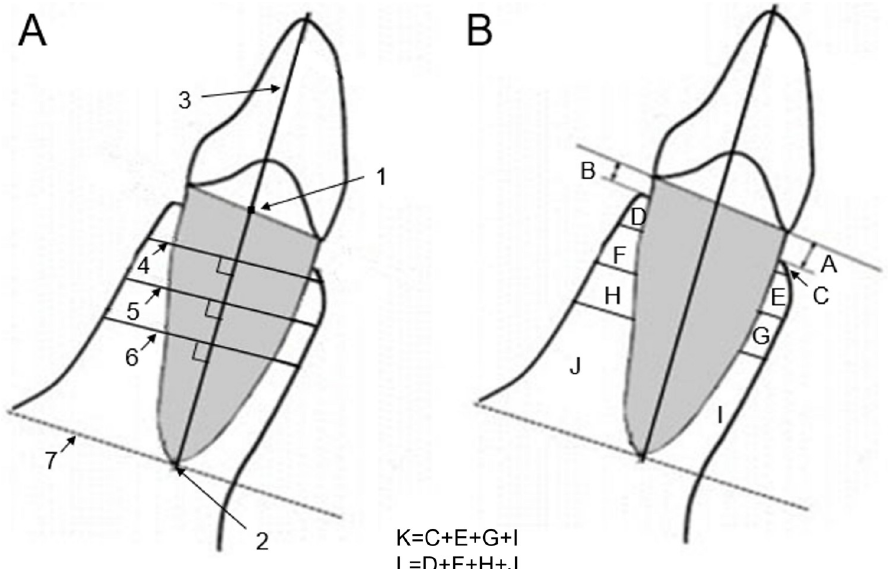
Fig 2. (A) Landmarks and reference planes . (1) midpoint of the CEJ line; (2) root apex (RA) point; (3) long axis (LA; a line from points 1 to 2); (4,5,6) intersecting line perpendicular to LA at the 2 mm, 4 mm, 6 mm below the CEJ line; (7) intersecting line perpendicular to LA at RA; (B) Variables : A and B, vertical alveolar bone level (distance from CEJ to alveolar crest parallel to LA); C and D, alveolar bone area (ABA) at 2 mm below the CEJ line; E and F, ABA at 4 mm below the CEJ line; G and H, ABA at 6 mm below the CEJ line; I and J, apical ABA; and K and L, total ABA on the labial (C+E + G + I) and palatal sides (D+F + H + J). Paired variables are the labial and palatal